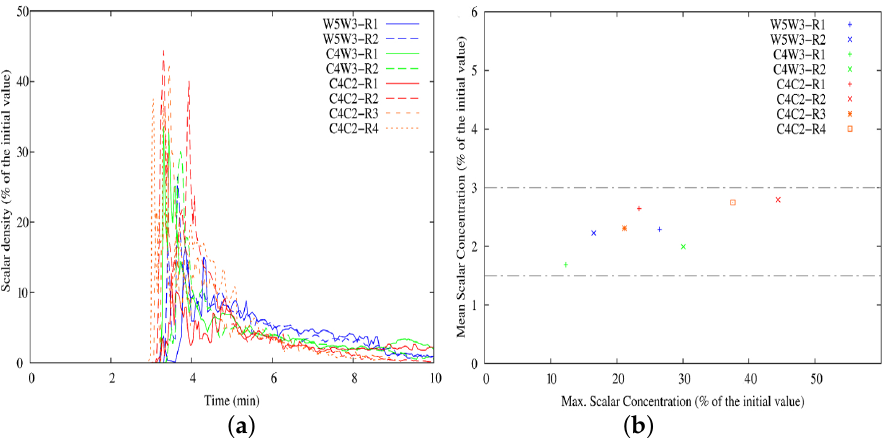
Figure 7. At the ’Maurice Jacquier’ primary school: ( a ) Temporal evolution of the scalar concentration (according to the initial value); ( b ) relationship between the mean and the maximum concentrations numerically observed within 15 min after the